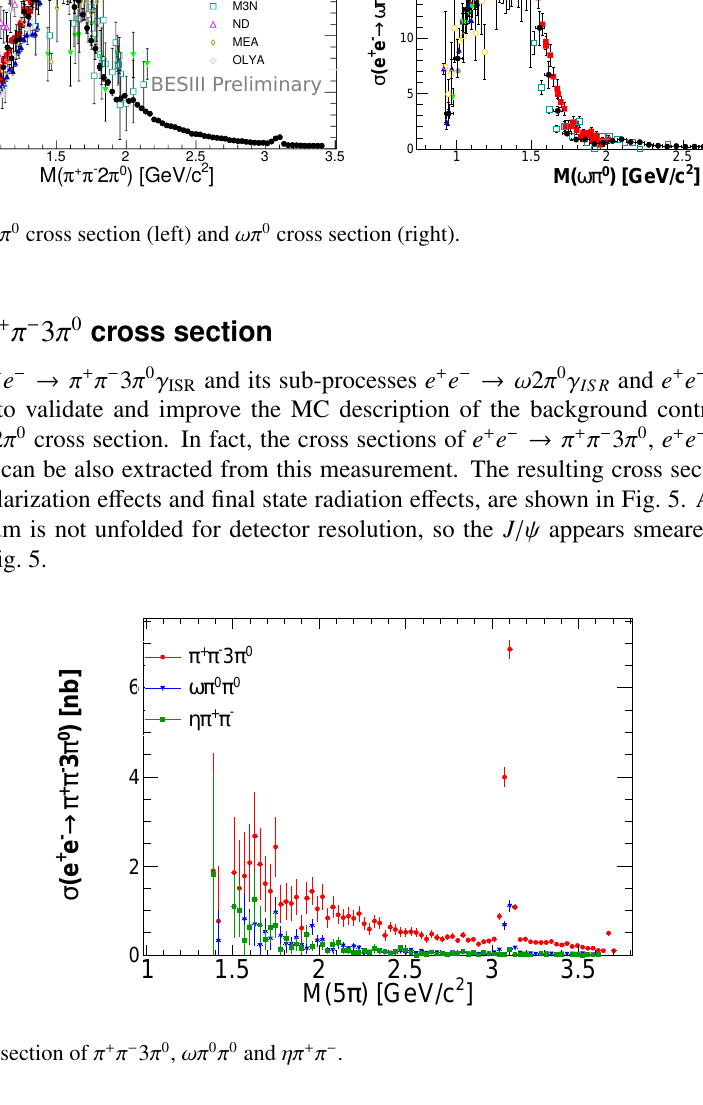
Figure 5. Cross section of π + π − 3 π 0 , ωπ 0 π 0 and ηπ + π −